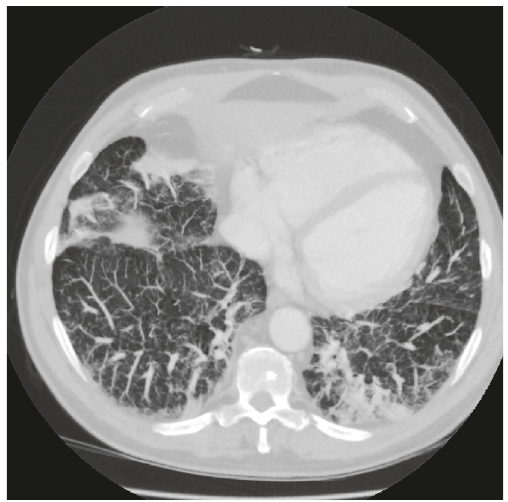
Figure 1: Chest computed tomography of the patient’s native lungs demonstrating a diffuse reticular, fibrotic, interstitial